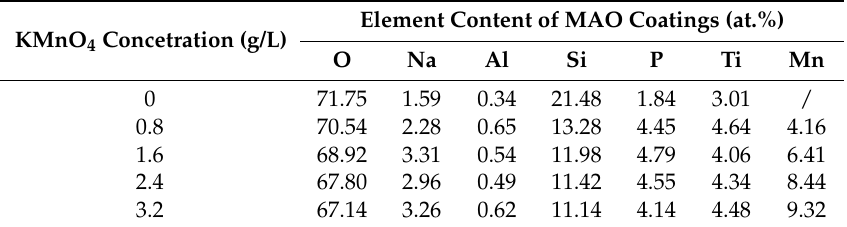
Table 2. Element content of MAO coatings at different KMnO 4 concentrations. KMnO 4 Concetration (g/L)